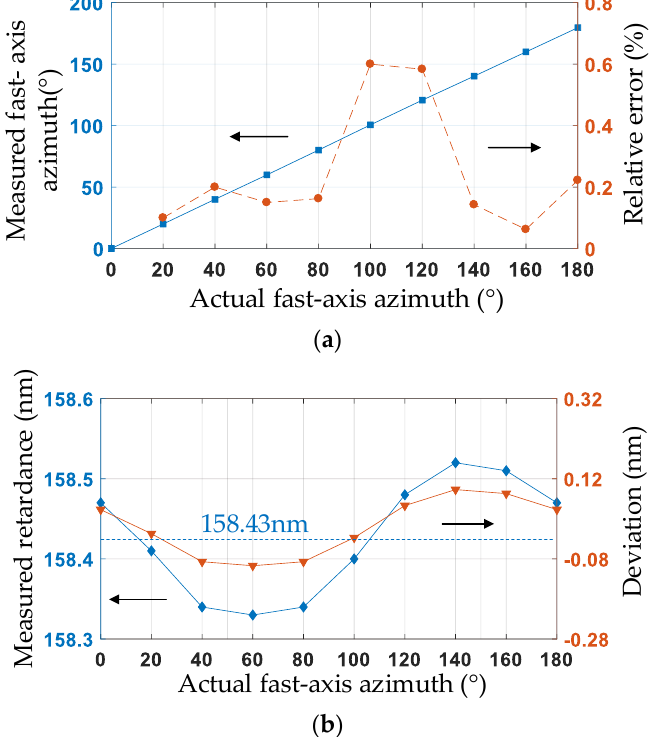
Figure 5. The 1/4 waveplate parameter experimental results under different angles: ( a ) fast-axis azimuth; ( b ) retardance at different fast-axis azimuths.